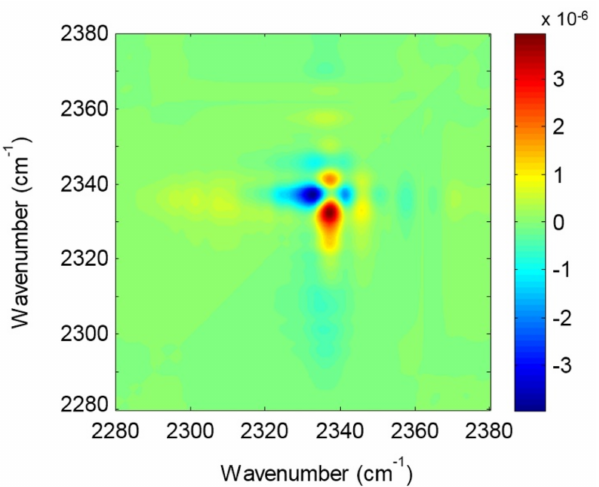
Figure 3. Asynchronous correlation spectrum in the 2280–2380 cm − 1 range relative to the isothermal measurement at 0 ◦ C.